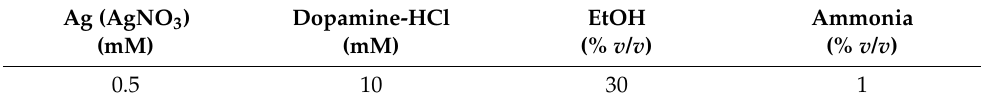
Table 1. Concentration of reagents and medium used in Ag-PDA